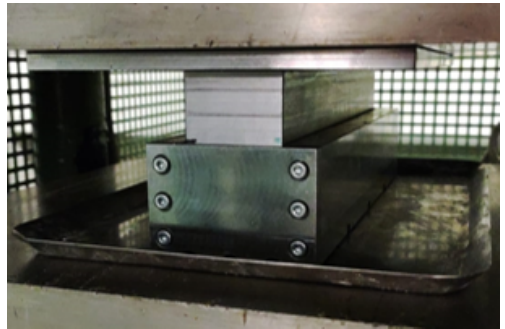
Figure 3. Mould utilised for the densification